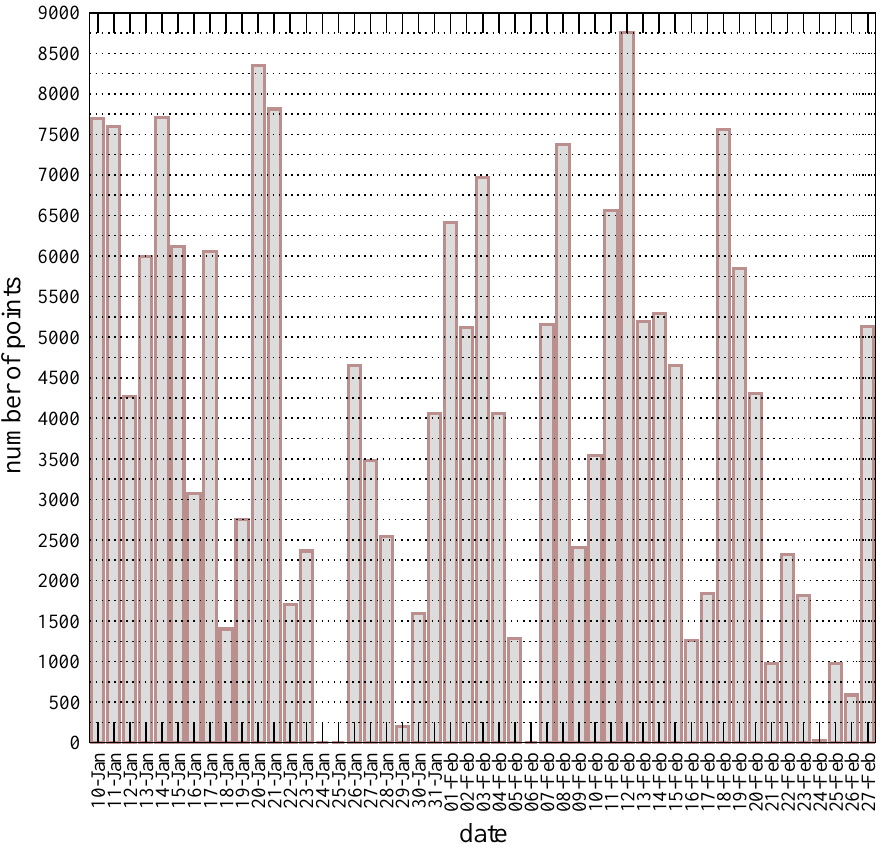
Fig. 4. Number of model grid points with satellite observations